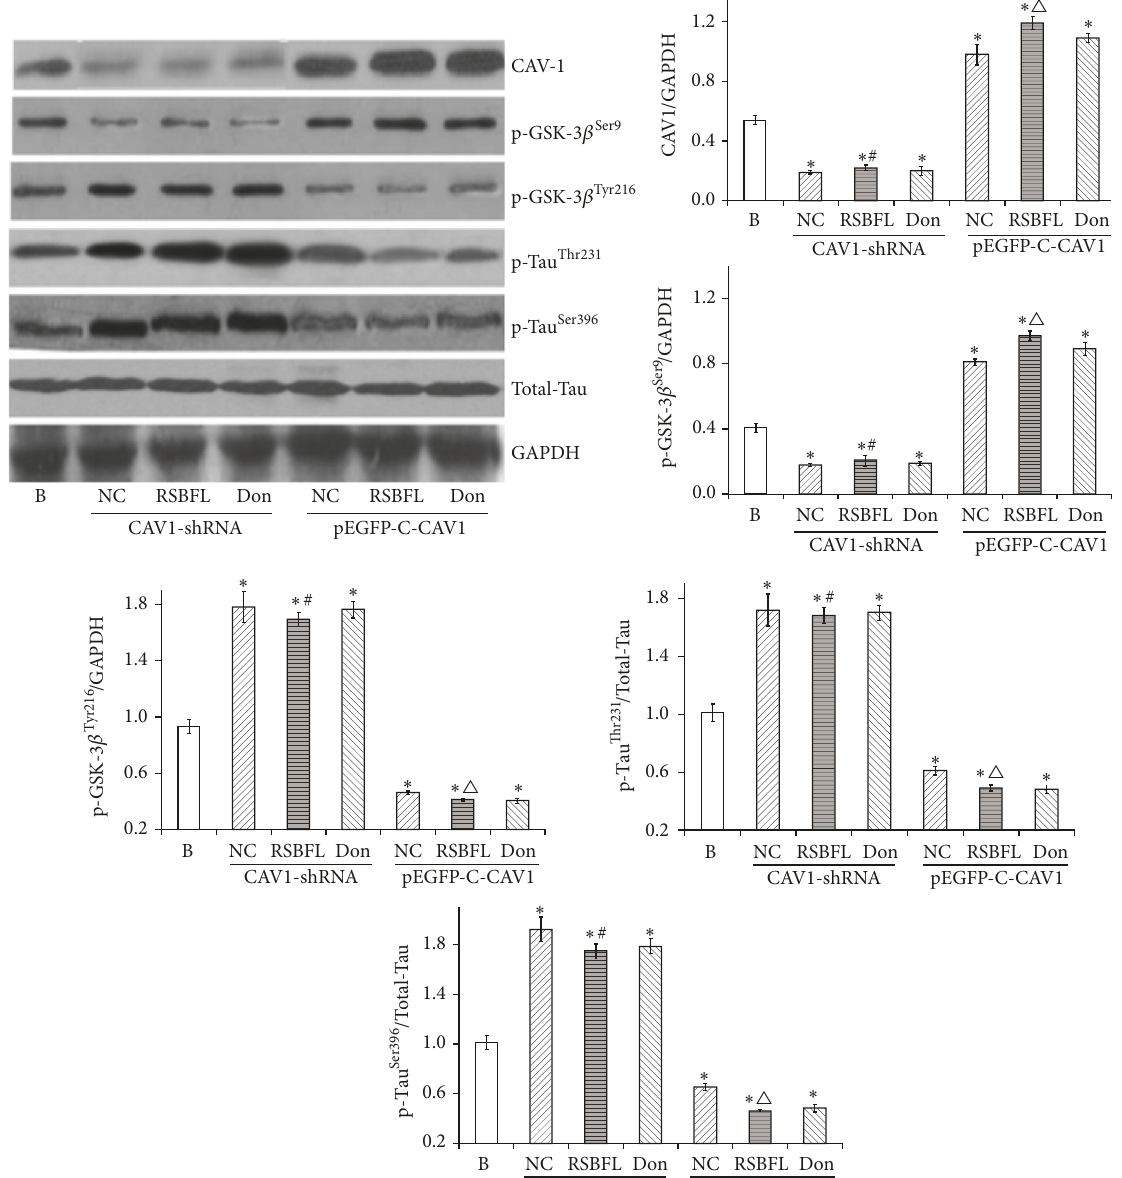
Figure 5: The expression of CAV1, p-Tau, and GSK-3 𝛽 in hippocampal neurons subjected to the treatments with sera containing RSBFL and donepezil in the presence and absence of CAV1-shRNA. ∗ 𝑃 < 0.05 relative to B group; # 𝑃 < 0.05 relative to NC group in CAV1-shRNA condition; △ 𝑃 < 0.05 relative to NC group in pEGFP-CAV1